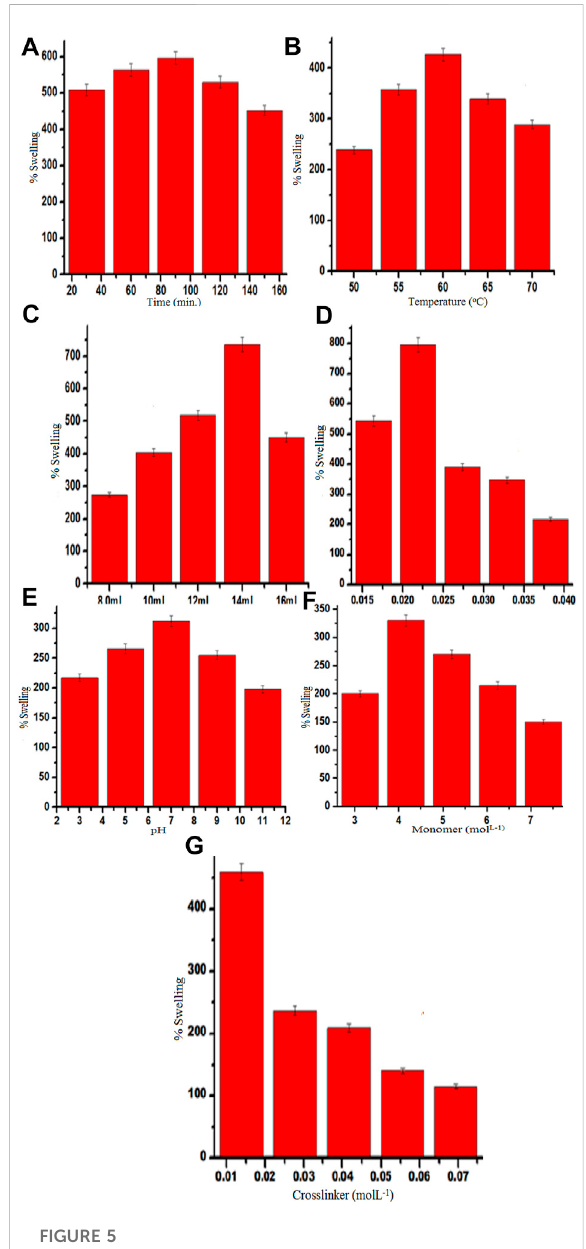
FIGURE 5 (A – G) Effect of time (A) , temperature (B) , solvent (C) , initiator concentration (D) , pH (E) , monomer concentration (F) , and crosslinker concentration (G) on the Ps of